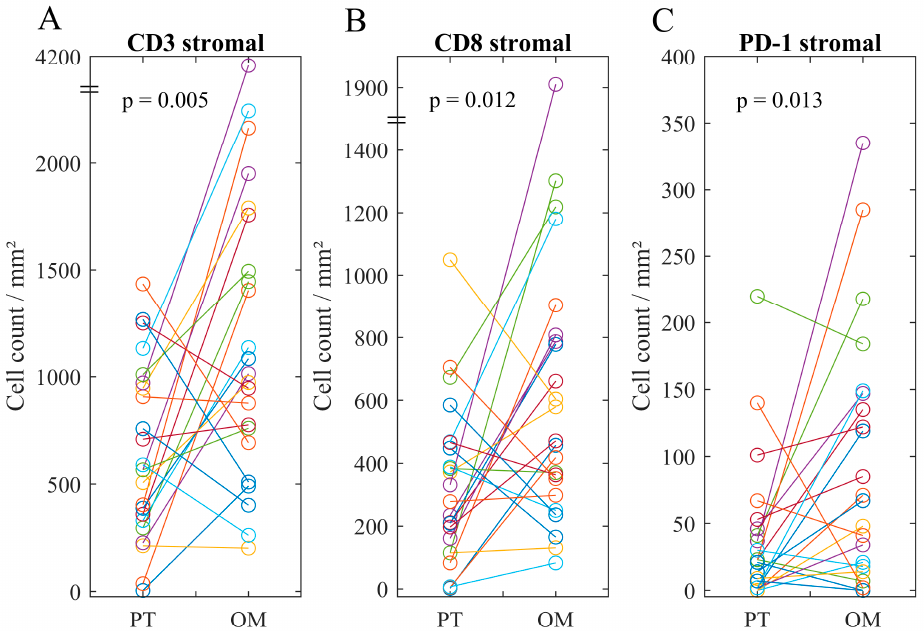
Figure 1. Scatter plots comparing immune cell phenotypes between primary tumor and the corresponding omental lesion. Counts of ( A ) CD3 + , ( B ) CD8 + , and ( C ) PD-1 + (programmed cell-death protein 1) stromal cells. Counts of CD3 + , CD8 + , and PD-1 + cells have been significantly higher in the omental lesions. p -value calculated by Wilcoxon signed-rank test.